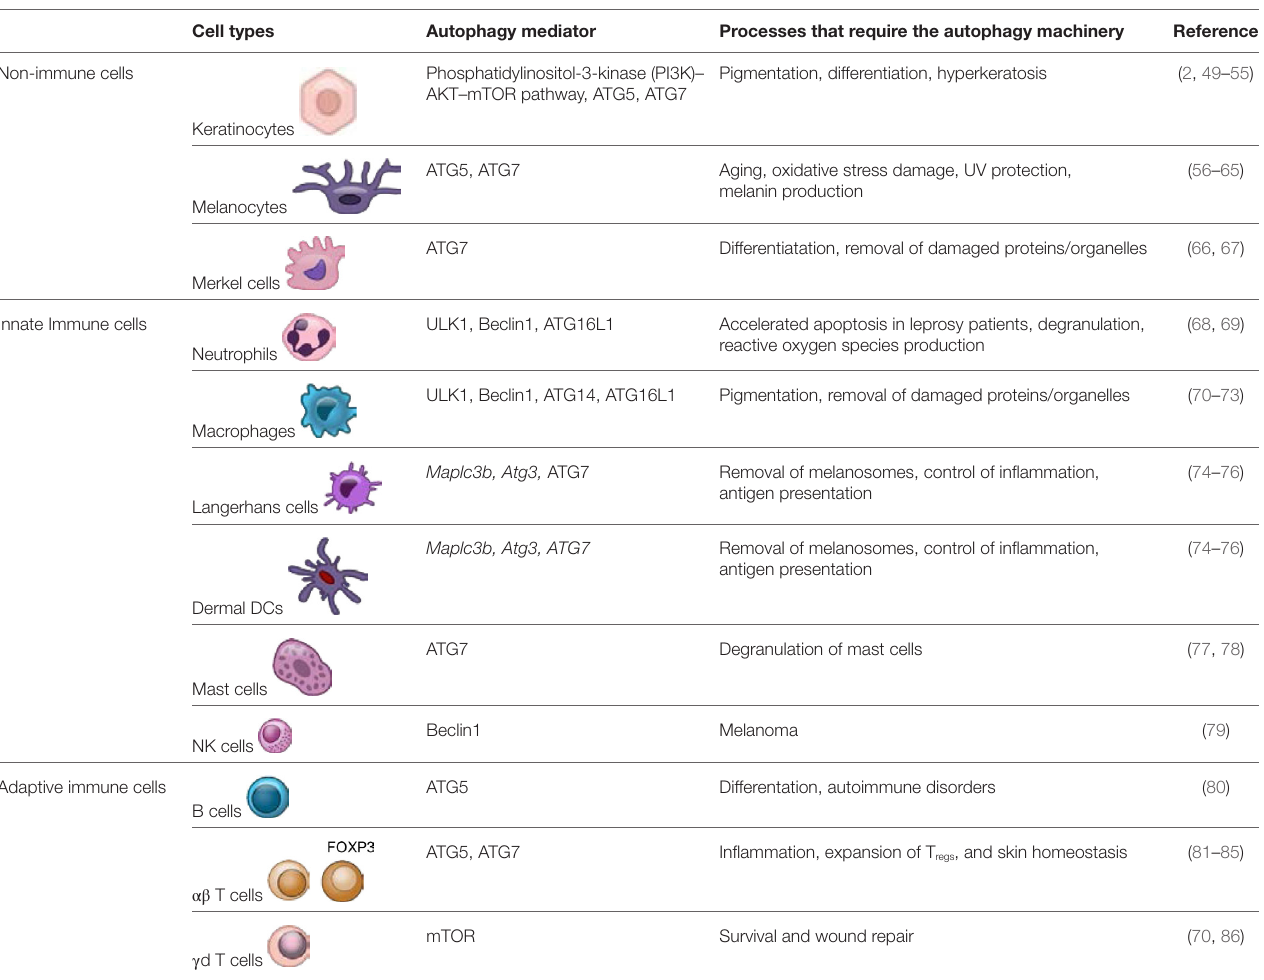
TABLe 1 | Lists the pertinent autophagy components active in skin